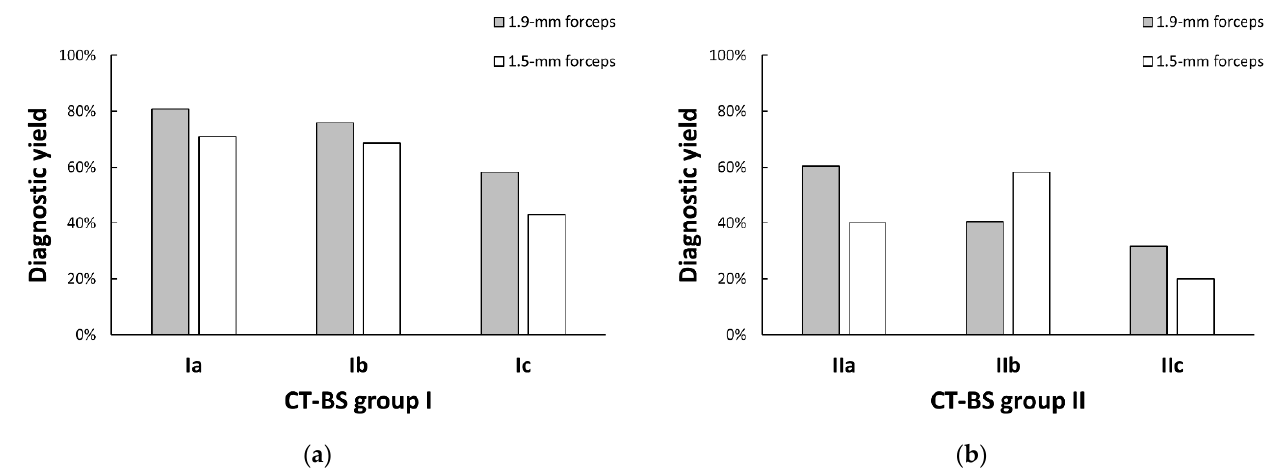
Figure 4. Diagnostic yields of each forceps in CT-BS groups ( a ) I and ( b ) II. The difference in diagnostic yield between the 1.9- and 1.5 mm forceps was the greatest in group Ic but not significant in CT-BS group I (58.2% [53 of 91] vs. 42.9% [6 of 14], p = 0.387). Compared with other bronchus types, 1.5 mm forceps cases had a higher diagnostic yield than 1.9 mm forceps cases in type IIb (58.1% [25 of 43] vs. 40.4% [19 of 47], p = 0.139). CT-BS, computed tomography bronchus sign.